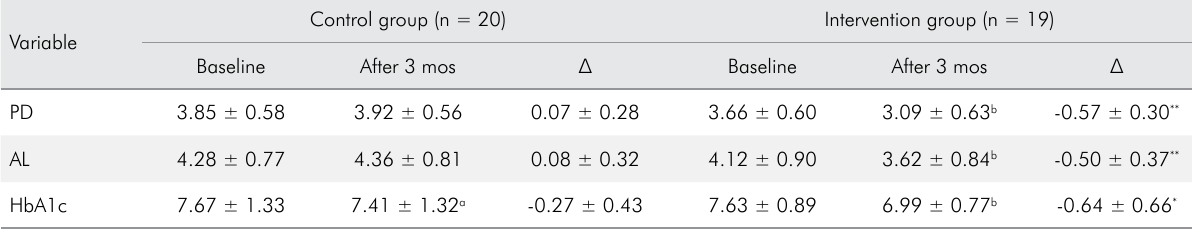
Table 2. Comparisons of the PD, AL and HbA1c levels in the two groups after three months.